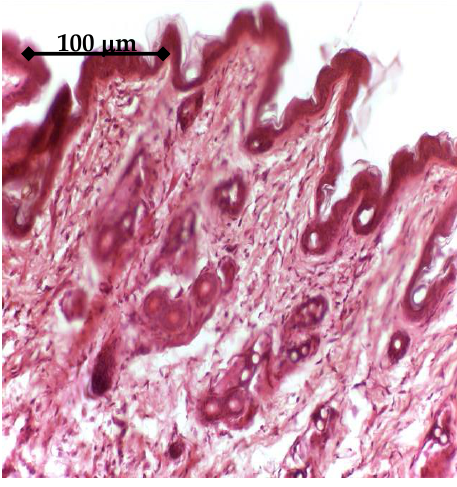
Figure 15. Tissue around IGF 1 Ti sample (14 days), Hematoxylin eosin staining: Superficial dermis with numerous bundles of collagen fibers, 20×.